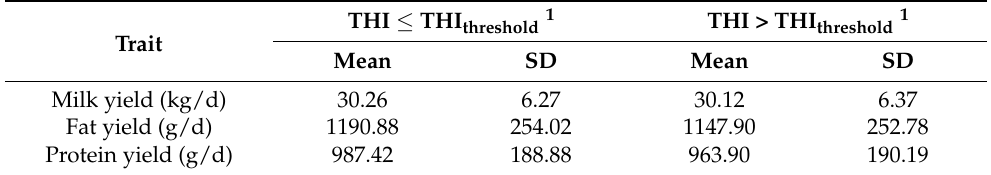
Table 1. Mean and standard deviation (SD) of test-day records for milk production traits below and above the temperature-humidity index (THI) threshold for milk, fat and protein yields.